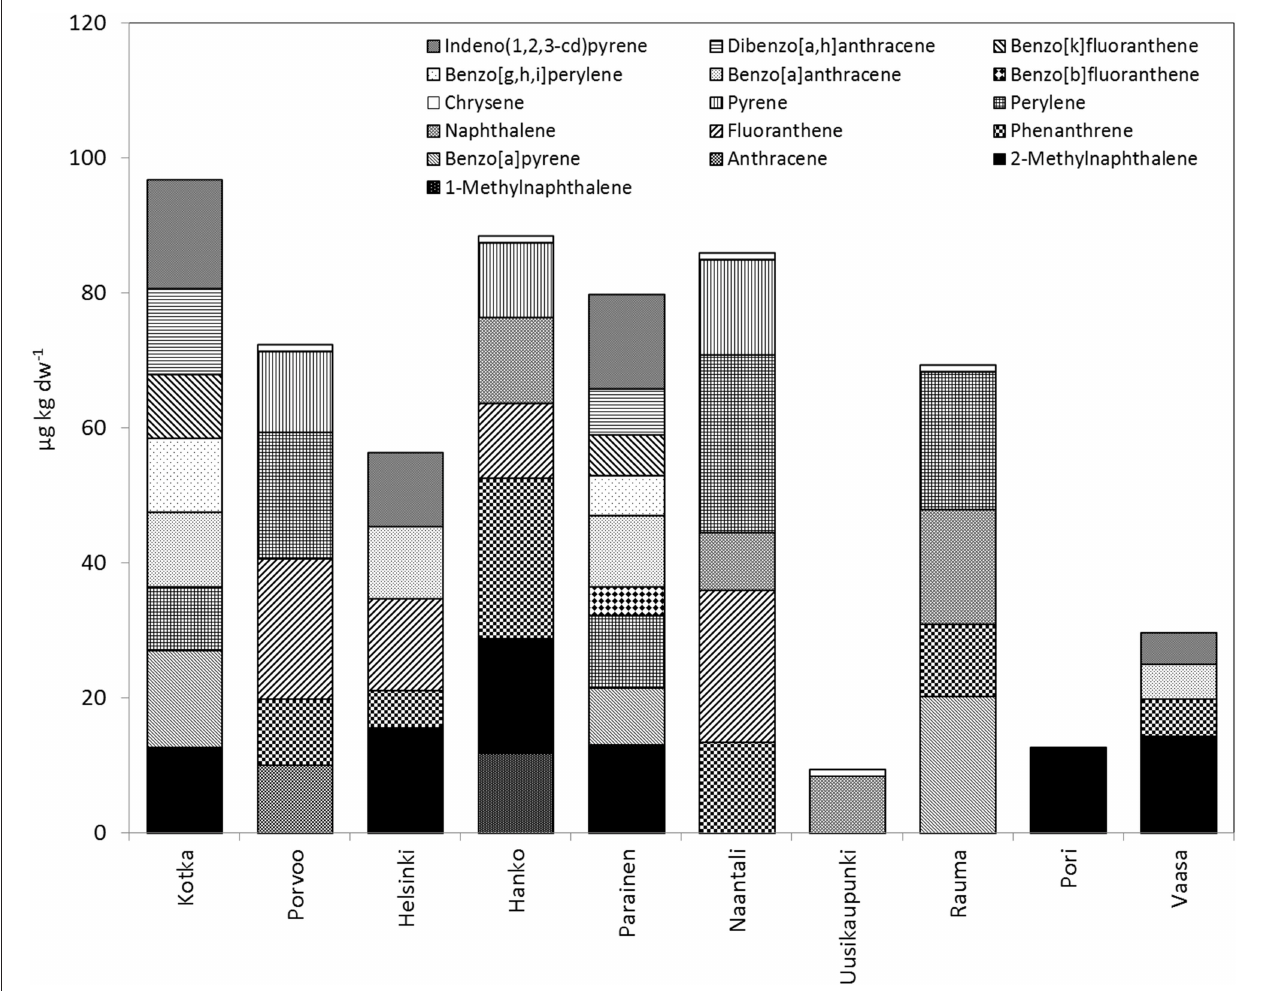
FIGURE 2 | PAH compounds ( µ g kg dry wt. − 1 ) in soft tissues of caged mussels from the study sites. Fluorene, acenaphthene, acenaphthylene, and benzo[e]pyrene were not detected in any of the samples.